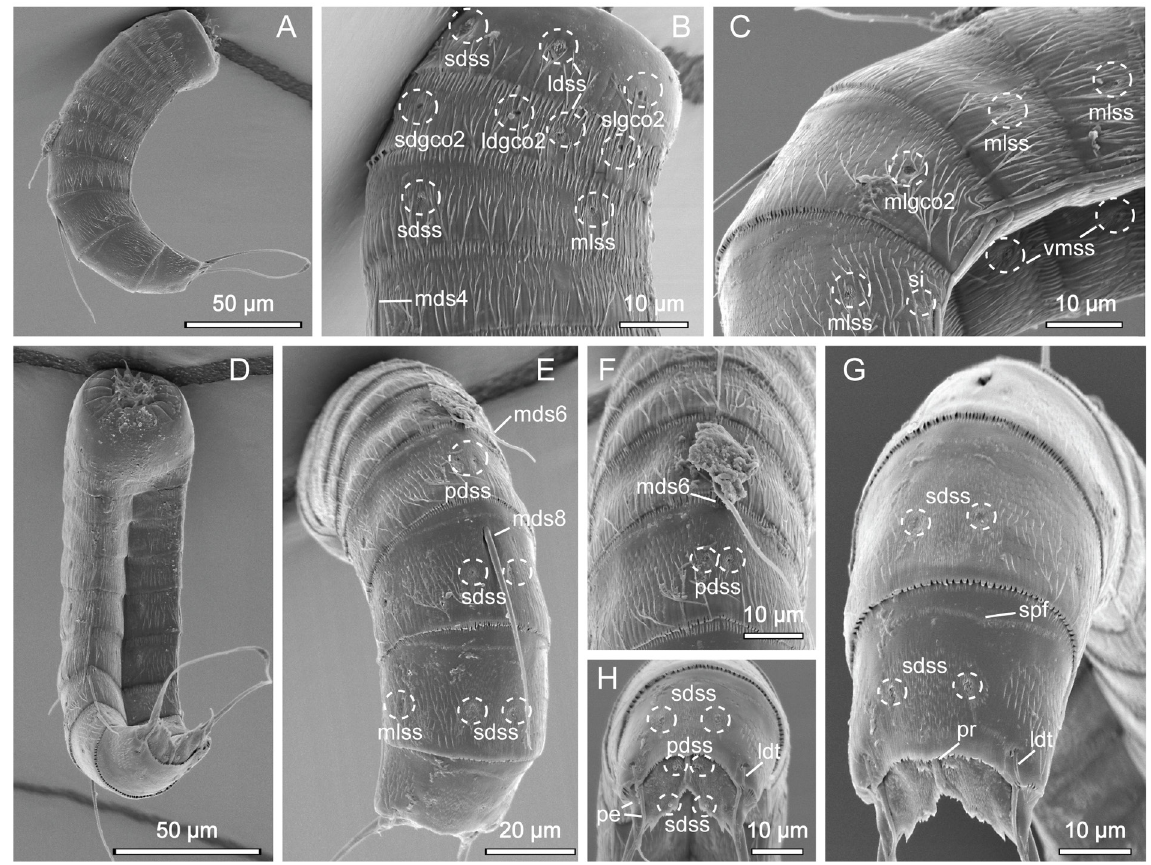
Fig. 25. Scanning electron micrographs showing overviews and details of Echinoderes legolasi sp. nov. A . Lateral overview. B . Segments 1 to 4, dorsolateral view. C . Segments 6 to 9, lateral view. D . Ventral overview. E . Segments 6 to 10, dorsal view. F . Segments 5 to 7, dorsal view. G . Segments 8 to 11, dorsal view. H . Segments 10 to 11, dorsal view. Abbreviations: see Material